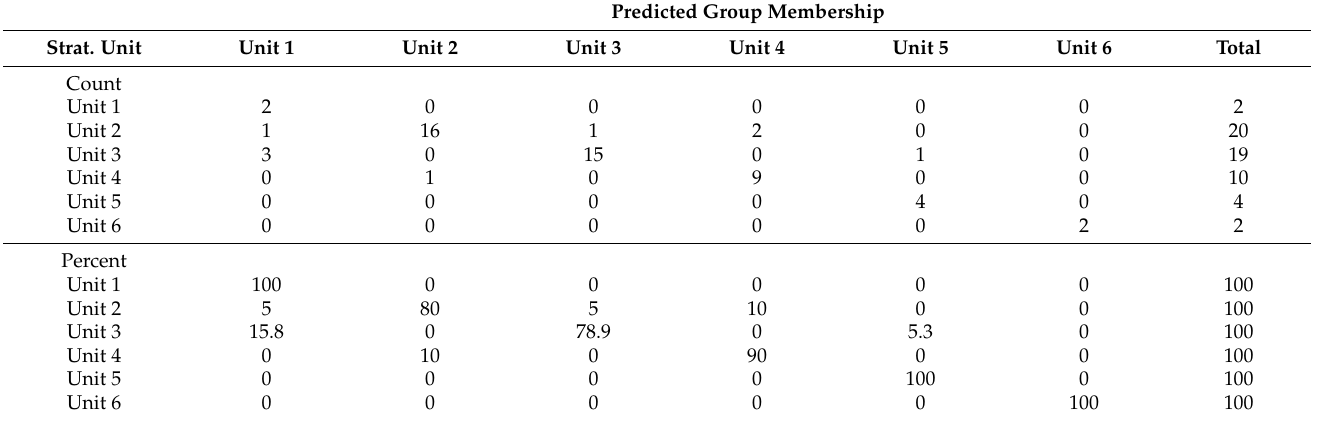
Table 5. Summary of samples from each chemostratigraphic unit within the precolonial deposits that were correctly classified by discriminant